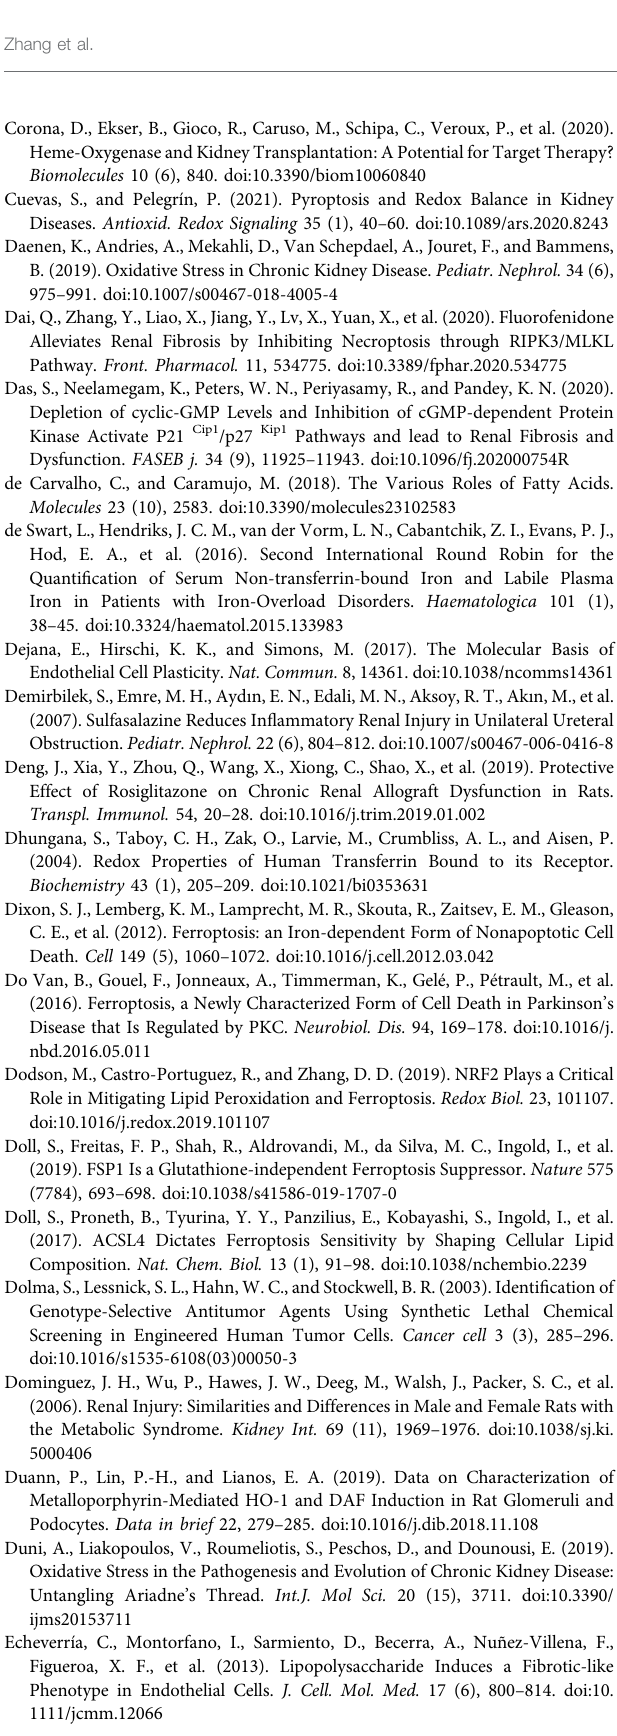
Figueroa, X. F., et al. (2013). Lipopolysaccharide Induces a Fibrotic-like Phenotype in Endothelial Cells. J. Cell. Mol. Med. 17 (6), 800 – 814. doi:10.